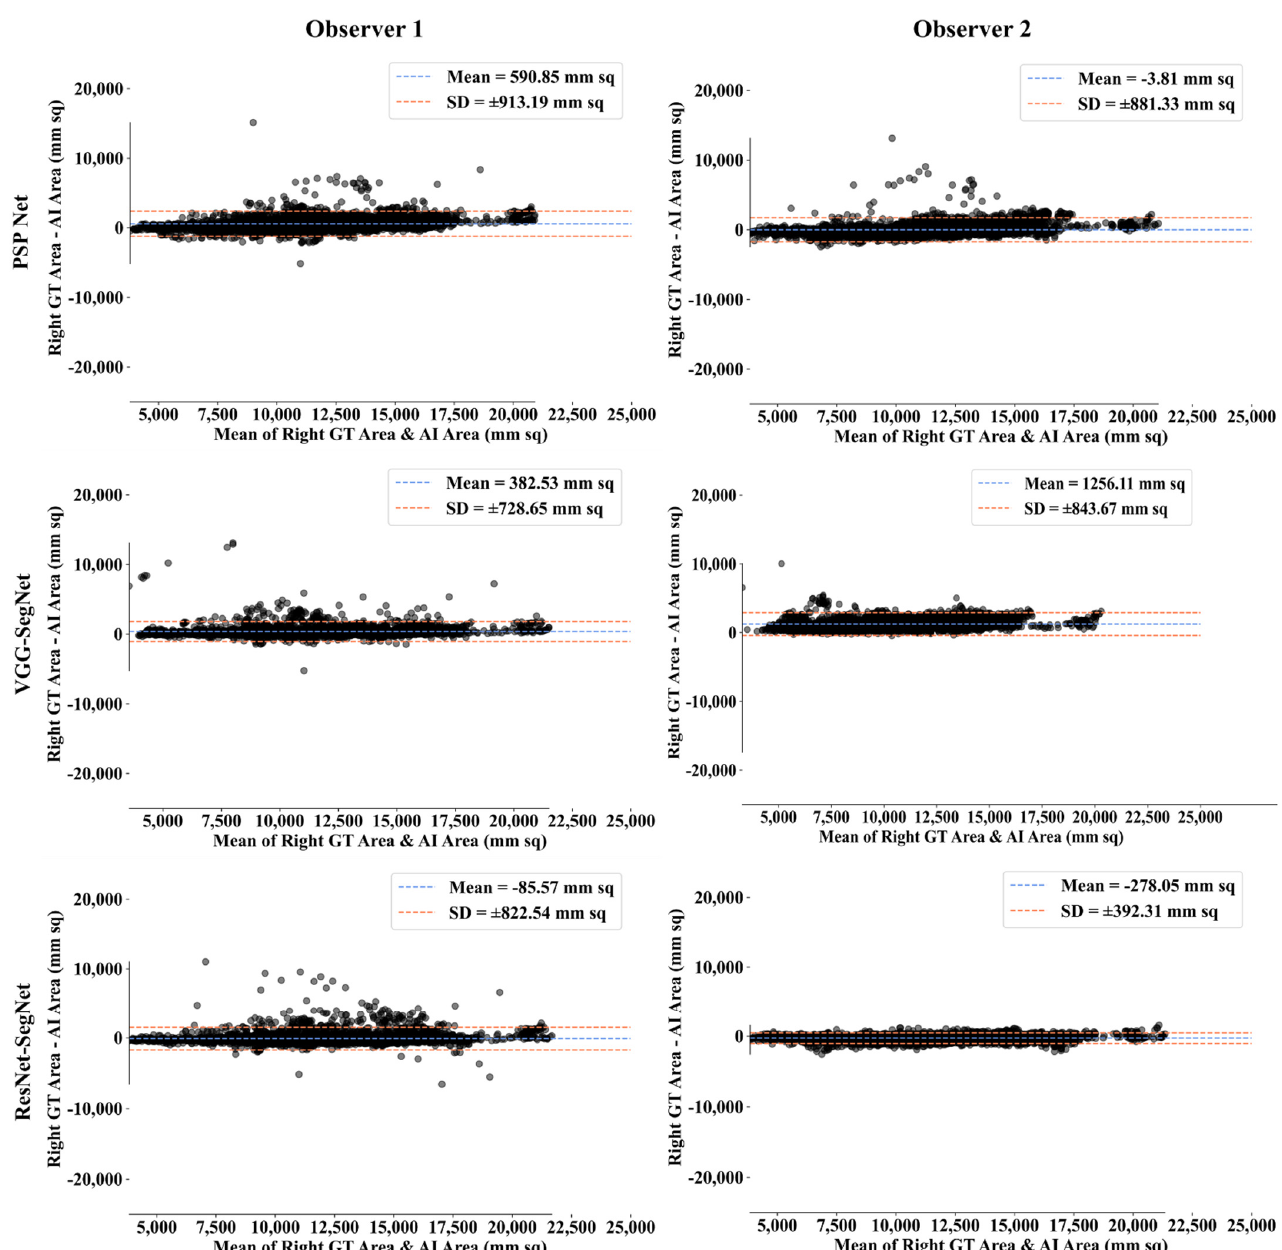
Figure 19. BA for right LA using three AI models: Observer 1 vs. Observer 2. ROC Plots for Lung Area